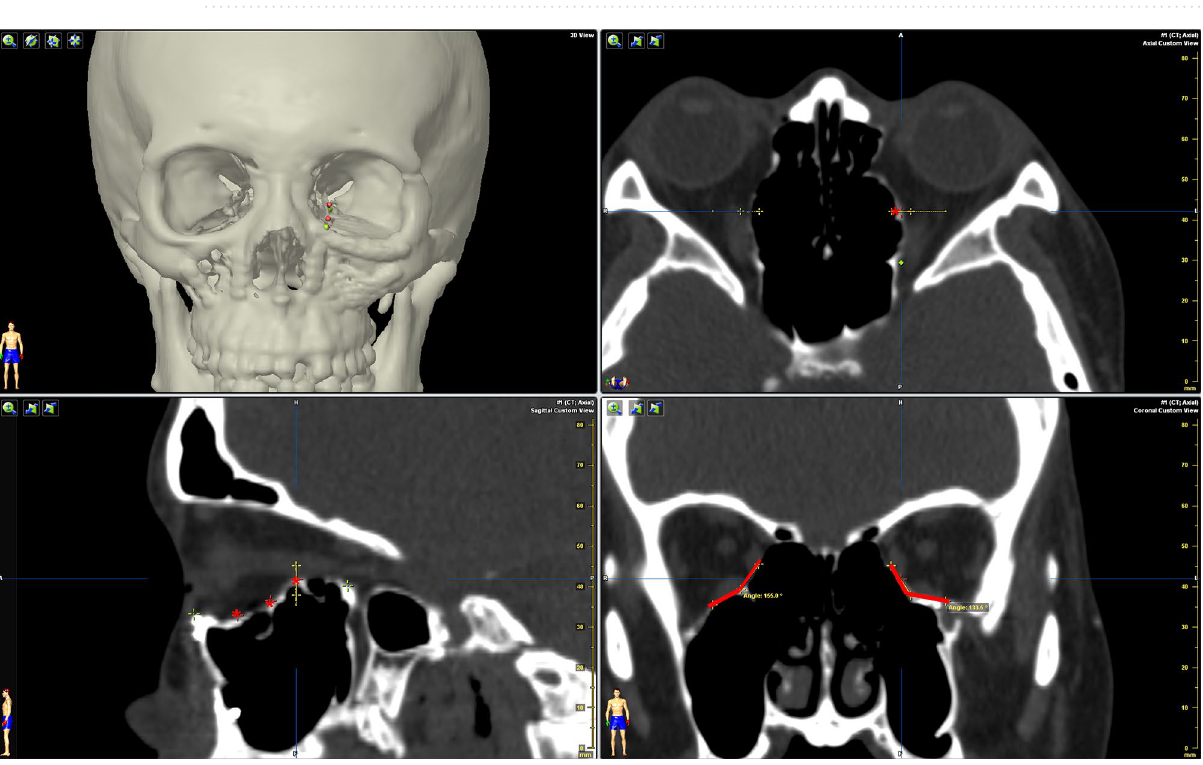
Figure 8. Measurements of bilateral orbital volume. The orbital volume was measured by the built-in function of object auto segmentation of the bilateral orbital cavity in the BrainLAB software. The fine adjustment of the object border was performed manually, and the orbital volume was obtained.